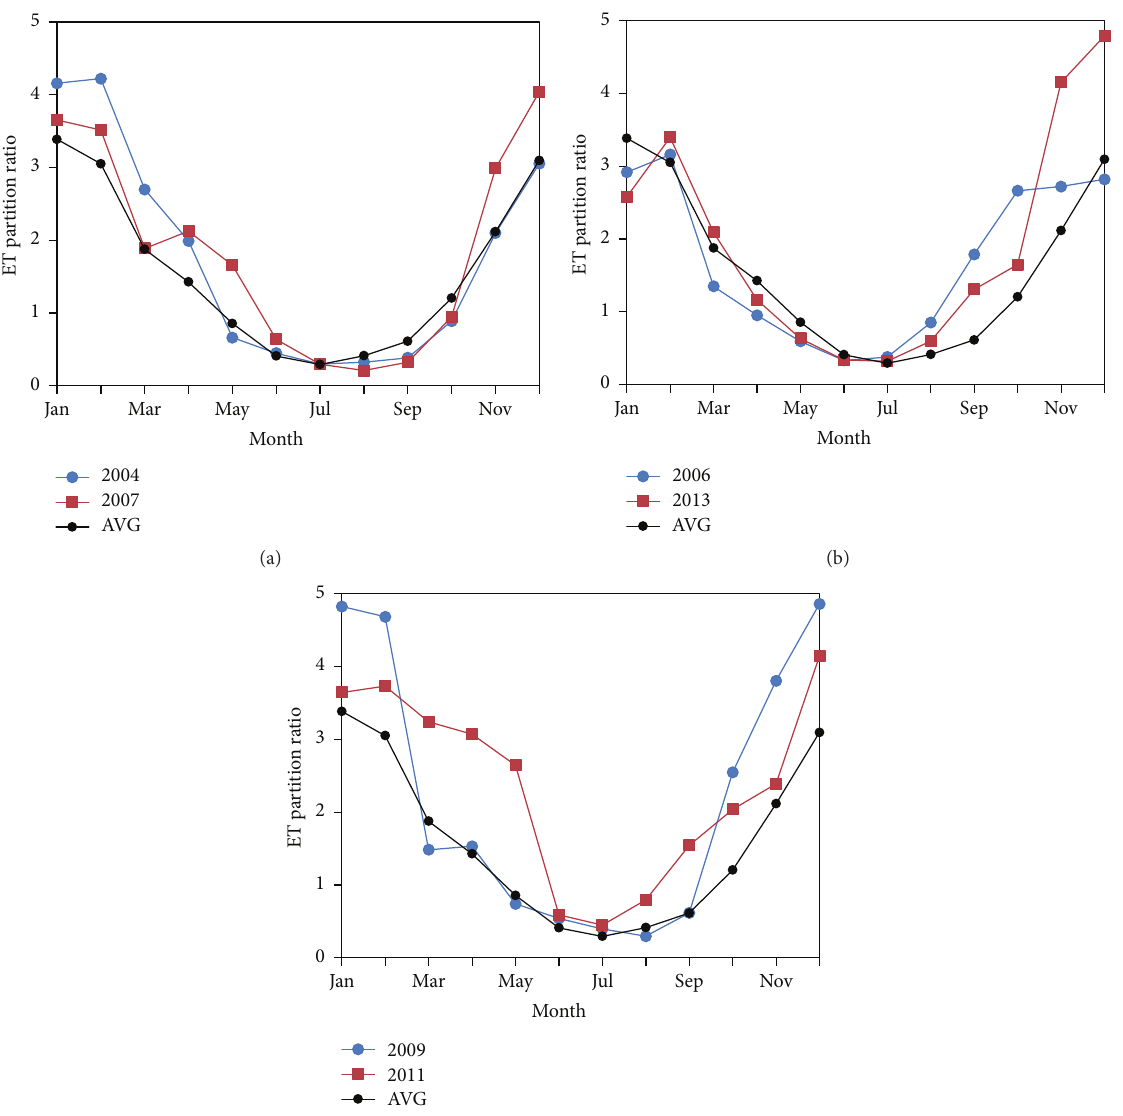
Figure 6: Monthly variations in the ET partition ratio during typical drought years. (a) Dry and rising; (b) flood and retreating; and (c) dry and